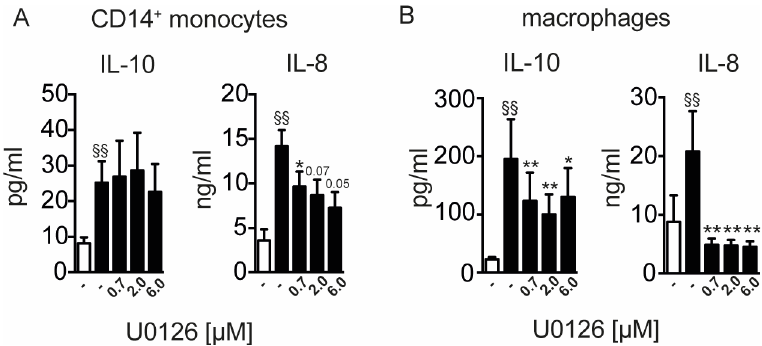
Fig 5. Induction of IL-10, but not IL-8 by rBmCPI-2 in human monocytes is independent of ERK. Human monocytes (A) and macrophages (B) were stimulatedwith 20 μ g/ml of rBmCPI-2 for 24 h with various concentrations of MEK1/2 inhibitor.Cytokines in the supernatants were detected by ELISA. Data are from 7–9 donorsand shown as mean ± SEM. Statistical analysiswas done using the Wilcoxon matched-pairssigned rank test. Valuesstatistically different from the unstimulated control are depicted as § p < 0.05and §§ p < 0.01. Valuesstatistically different from rBmCPI-2-stimulatedmonocytesare depicted as * p < 0.05 and ** p < 0.01.